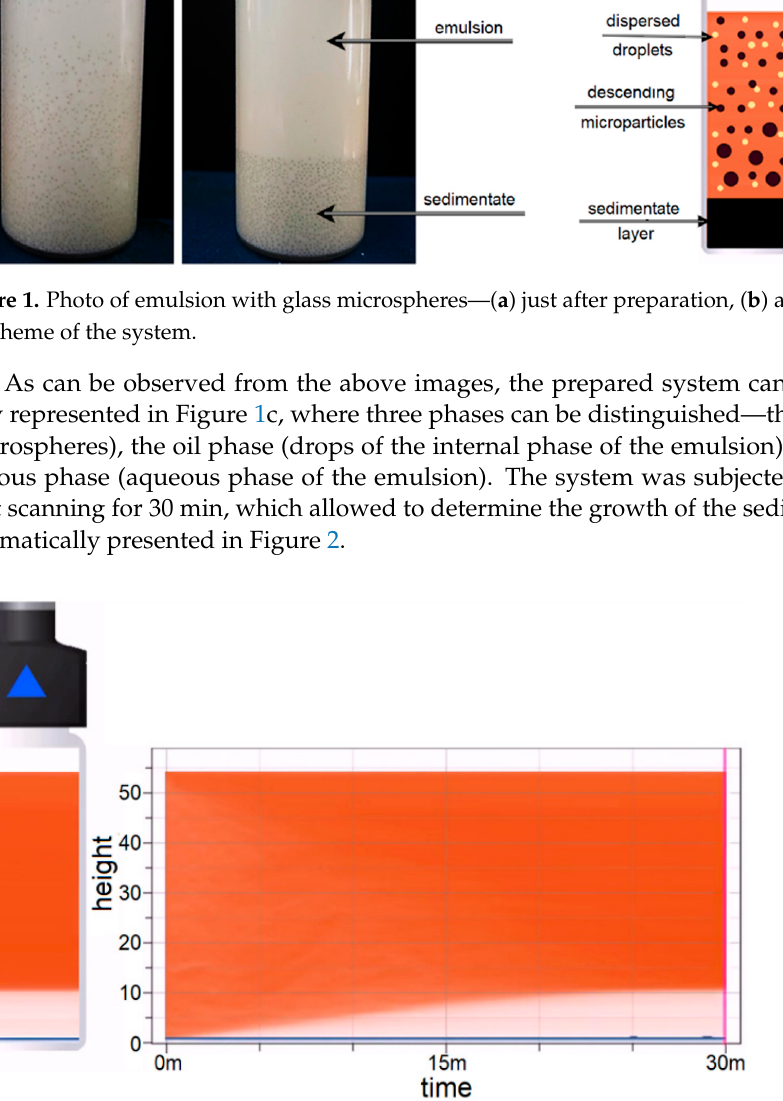
Figure 2. Increase in sediment thickness over time for a measurement of 70% emulsion (D 1 ), with 0.3 g/mL of glass microspheres in the 300–400 μ m diameter range.